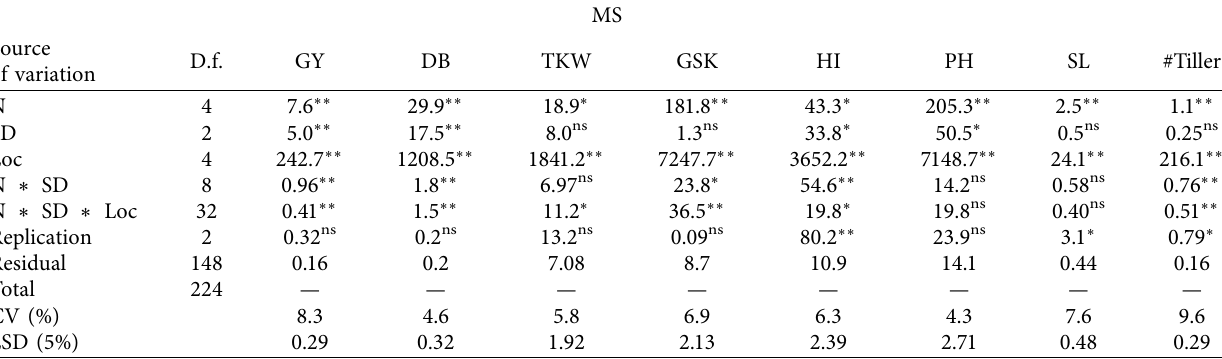
Table 3: Analysis of variance of applied N and seeding rates in Jimma Arjo, Jimma Geneti, Wayu Tuka, Horo, and Degem districts in 2020 season under irrigation